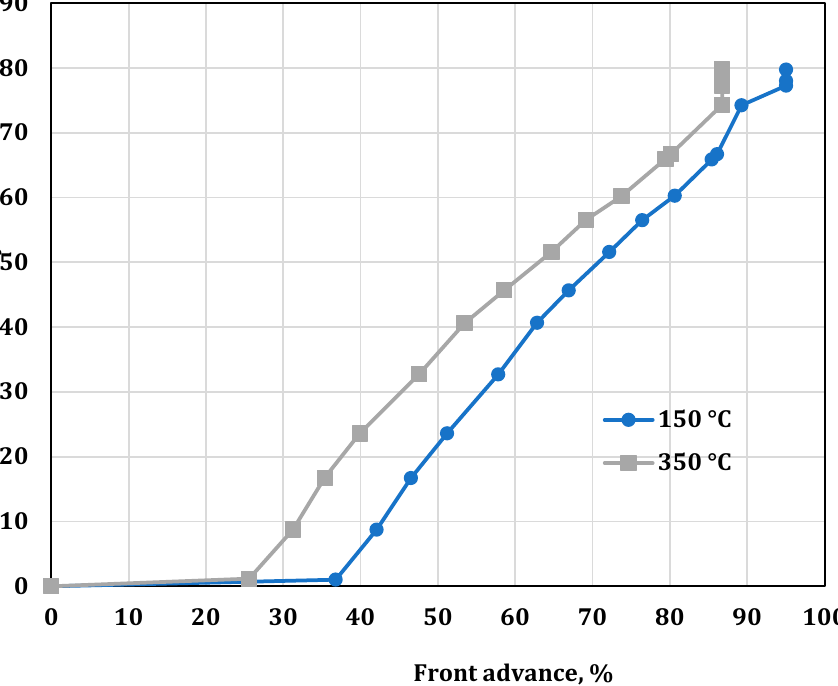
Figure 17. Oil recovery vs. front advancement.